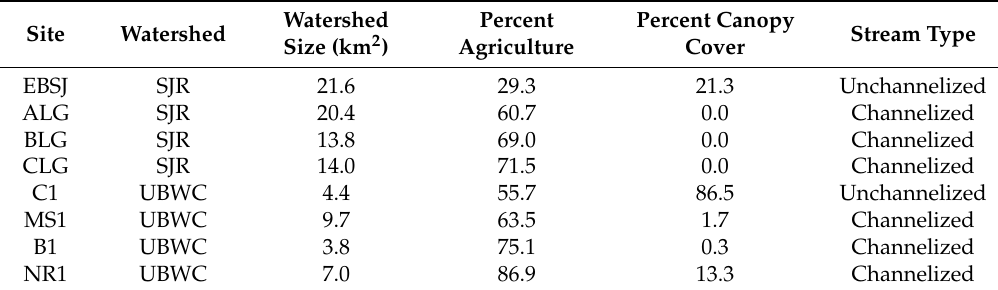
Table 1. Watershed size, percent agriculture land use in watershed, mean percent riparian canopy cover, and stream type of four sites in the Saint Joseph River watershed (SJR) and four sites in the Upper Big Walnut Creek watershed